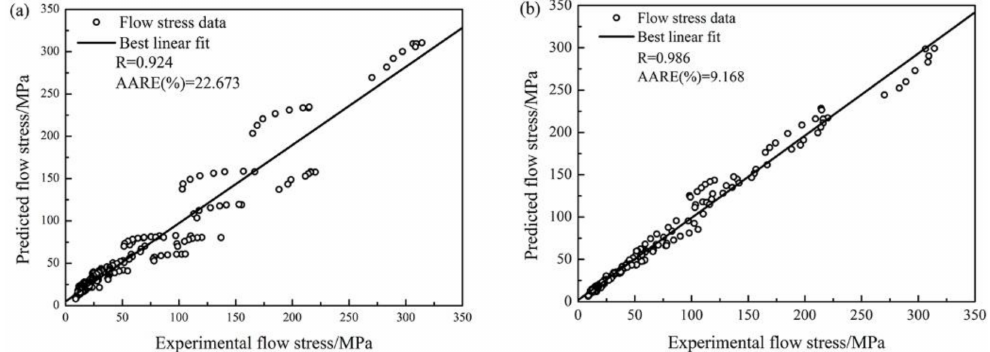
Figure 14. Correlation between the experimental and predicted flow stress data ( a ) the modified Johnson–Cook constitutive model; ( b ) the strain compensated Arrhenius-type constitutive